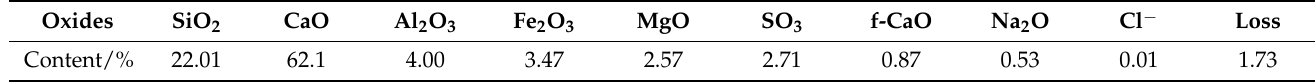
Table 1. The chemical compositions of Portland cement used in this study (wt, %).